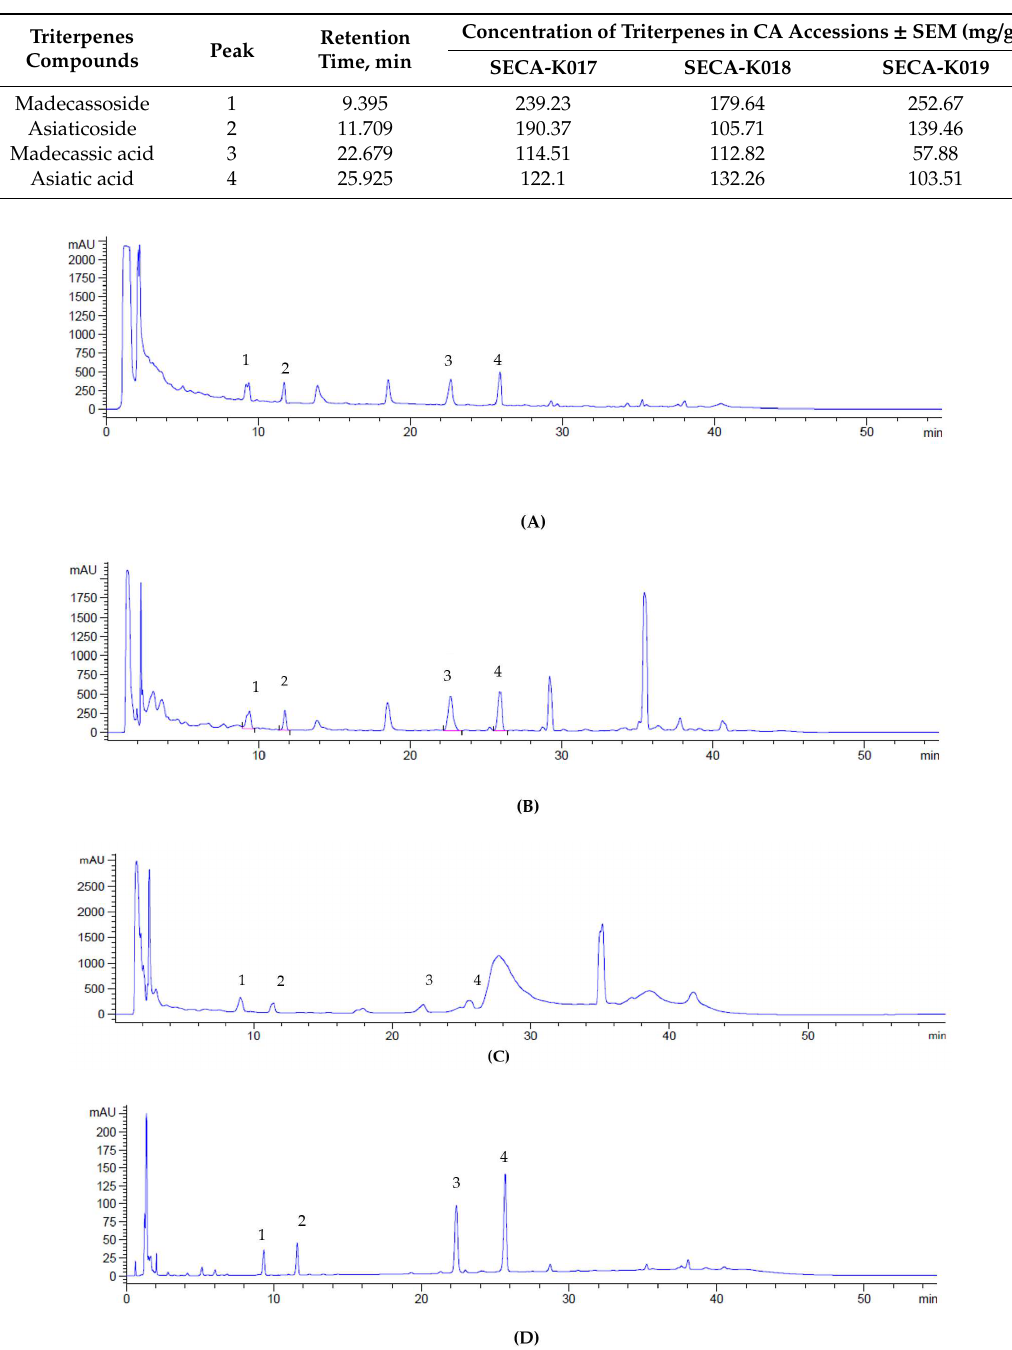
Figure 2. Chromatogram of standardized extracts of CA accessions; SECA-K017 ( A ), SECA-K018 ( B ), SECA-K019 ( C ) and reference standards mixture ( D ). (1) madecassoside; (2) asiaticoside; (3) madecassic acid; (4) asiatic acid.